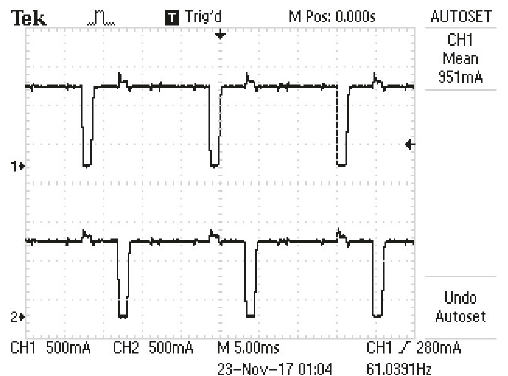
Figure 2: Output current for the two parallel-connected MPPT